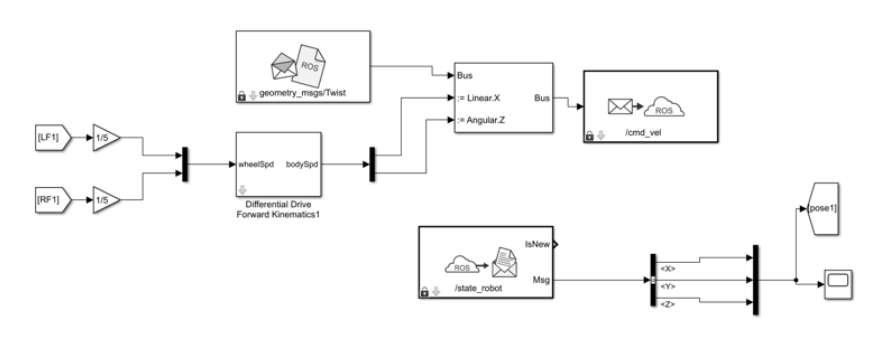
Fig. 10. MATLAB interaction scheme in ROS Toolbox package.